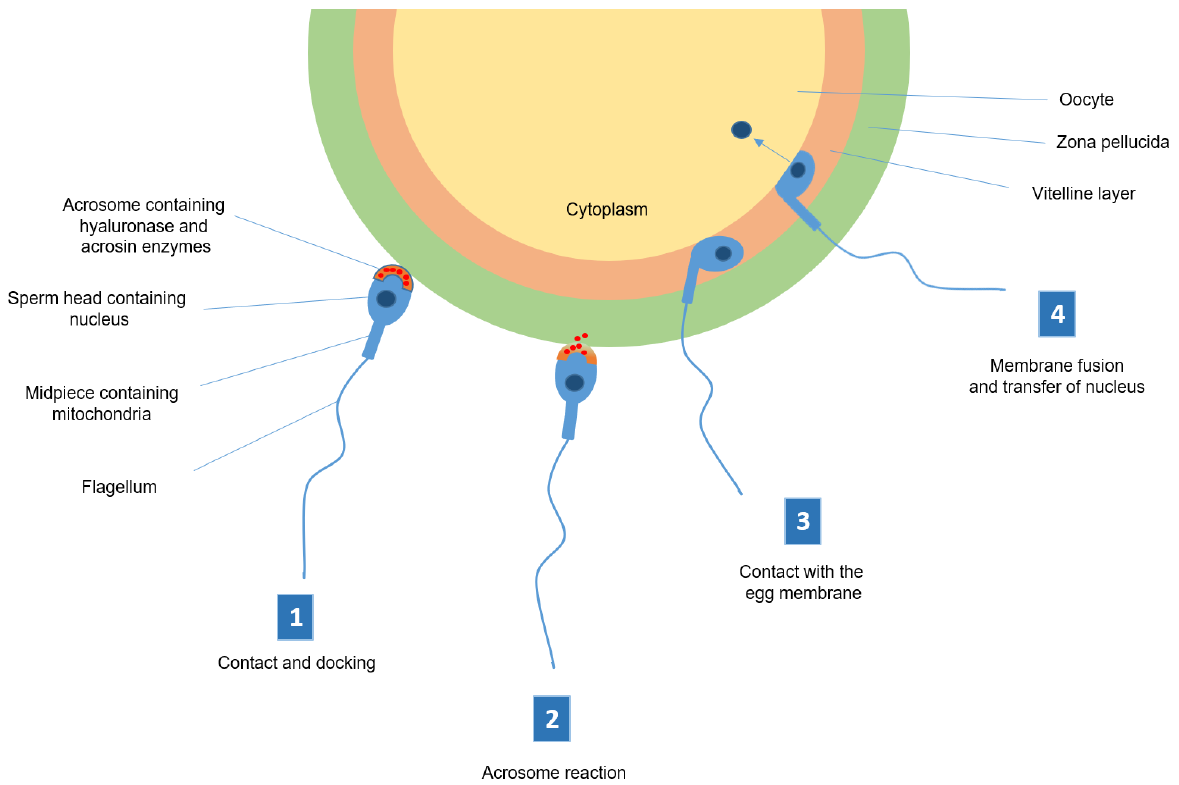
Figure 3. Schematic diagram of the acrosome reaction and fertilization. 1) Sperm cells are chemo-attracted to the oocyte and once in close proximity, interact with zona pellucida (ZP) glycoproteins. The arrangement of these glycoproteins are species specific and